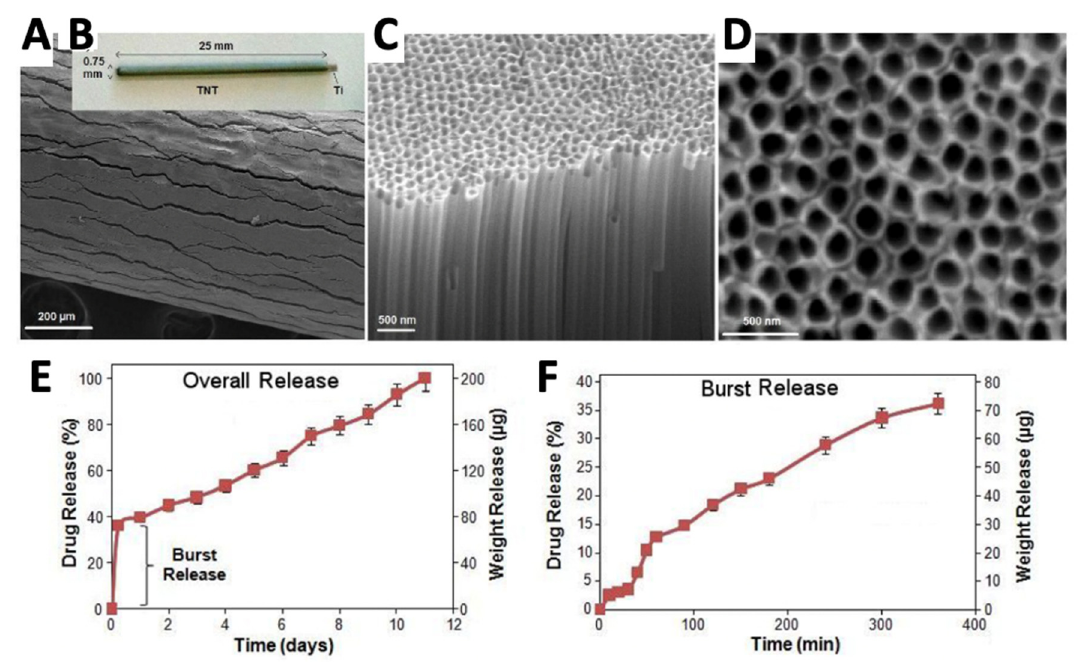
Figure 5. SEM images of titania nanotubes (TNT) grown on Ti wire using the anodization technique. ( A ) The top surface showing cracks, ( B ) the entire structure showing TNT on Ti wire with dimensions, ( C ) the cross-section showing array of TNTs and ( D ) the hollow nanotubes. ( E ) Overall release and ( F ) burst release of gentamicin (corresponding to the first 6 h of fast diffusion of drug) from TNT-Ti wire. Modified and reproduced from [216] CC BY 2.0 http://creativecommons.org/licenses/by/2.0 (accessed on 18 October 2022).